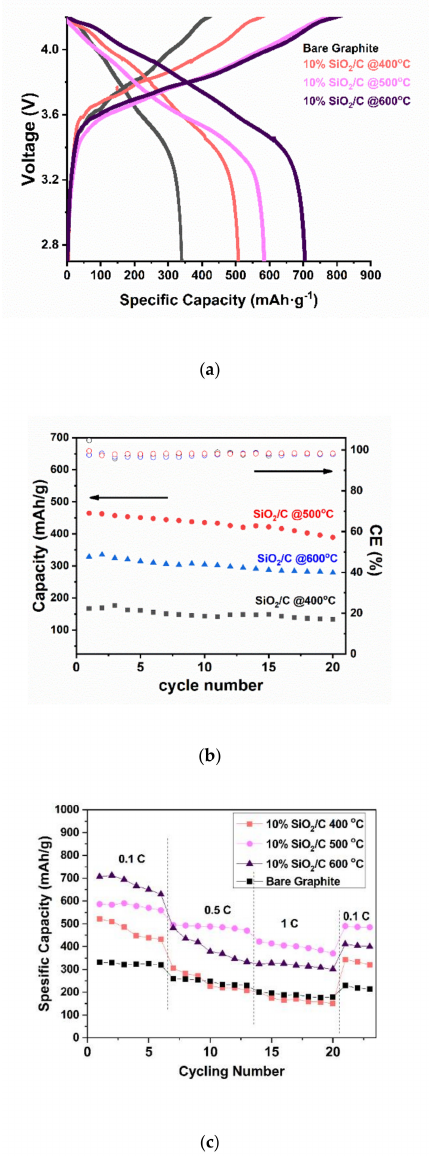
Figure 9. ( a ) Initial charge / discharge curve of the SiO 2 / C composite at 0.1 C; ( b ) cycling performance of the SiO 2 / C composite; ( c ) rate performance of the SiO 2 / C composite at various